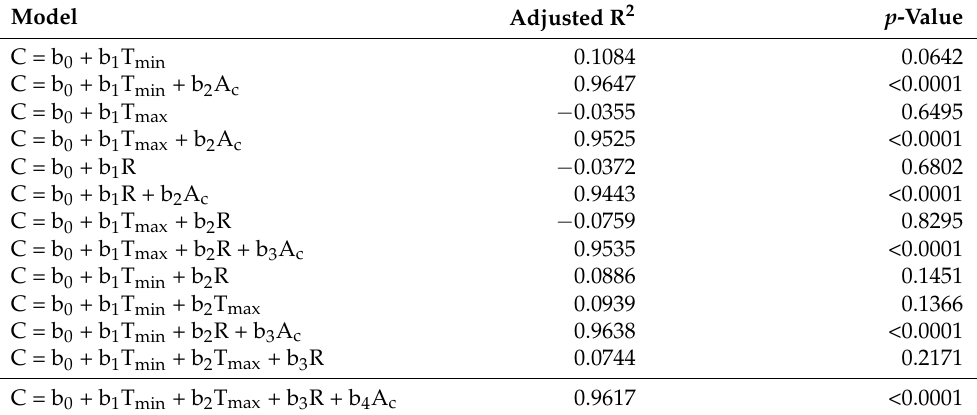
Table 1. Adjusted R 2 values for all possible linear regression models for cassava